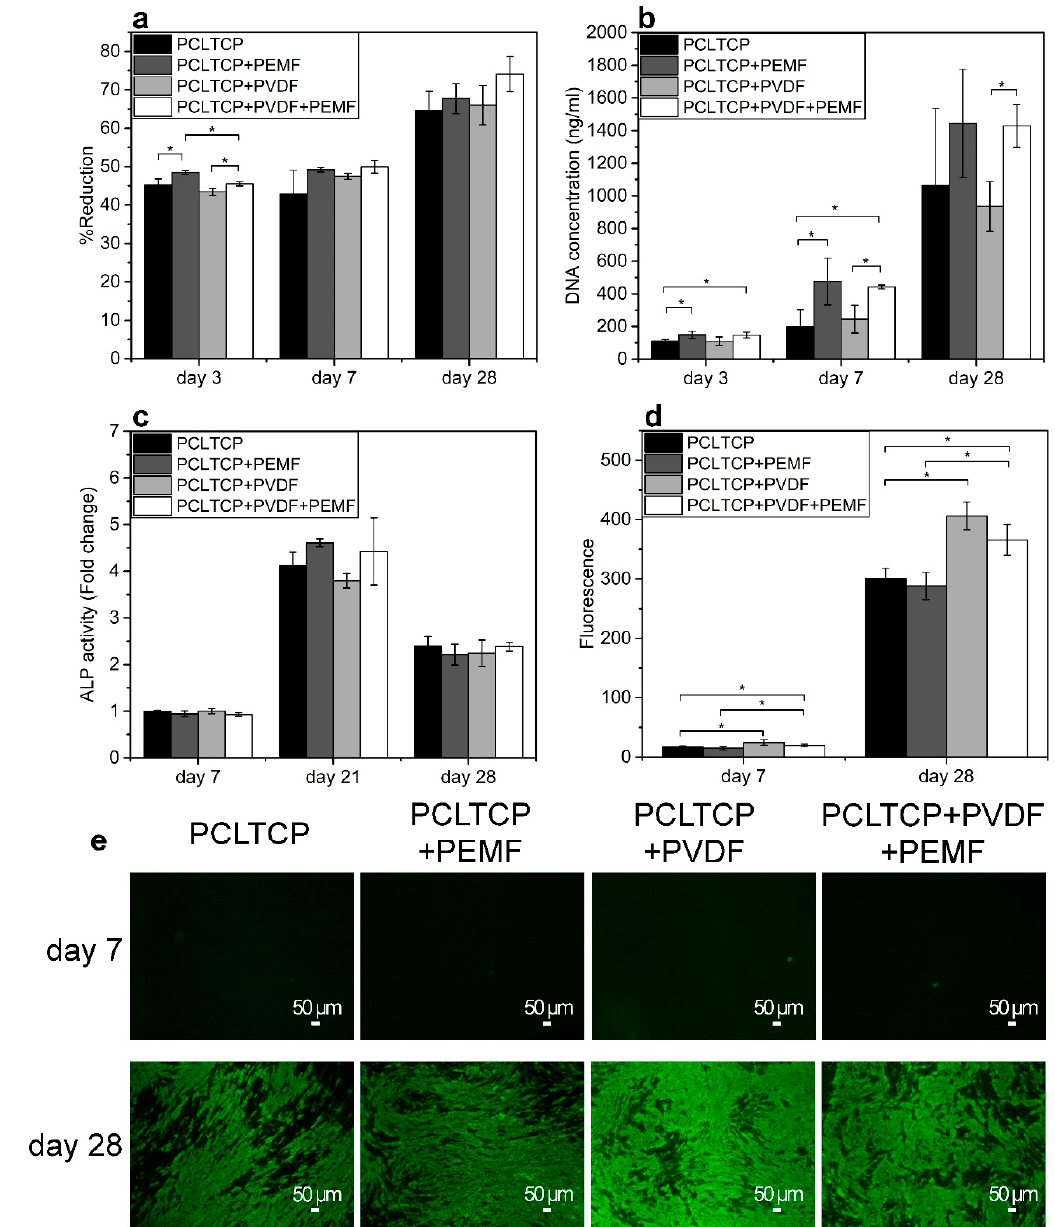
Figure 4. ( a ) Cell metabolic activity by measuring the percentage of alarmaBlue reduction. ( b ) Cell proliferation quantified by DNA quantification. ( c ) Alkaline phosphatase (ALP) activity. ( d ) Quantification of Osteoimage fluorescence. ( e ) Osteoimage staining of hydroxyapatite rich regions (green). Sample groups: PCL-TCP without (PCL-TCP) and with PEMF (PCL-TCP+PEMF), PVDF-coated PCL-TCP without (PCL-TCP+PVDF) and with PEMF (PCL-TCP+PVDF+PEMF) (* p < 0.05, n = 3).